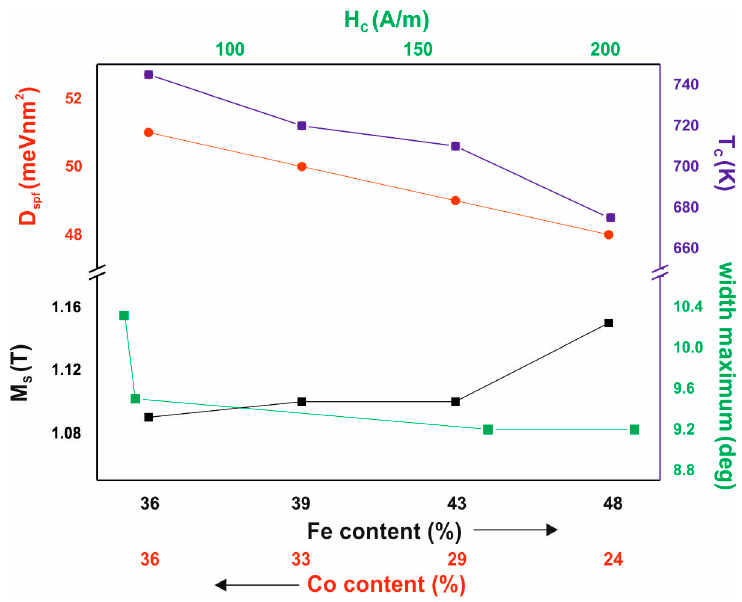
Figure 10. Dependence of magnetic properties on the proportions of Fe and Co and the relationship of the coercive field with the width of the amorphous halo.